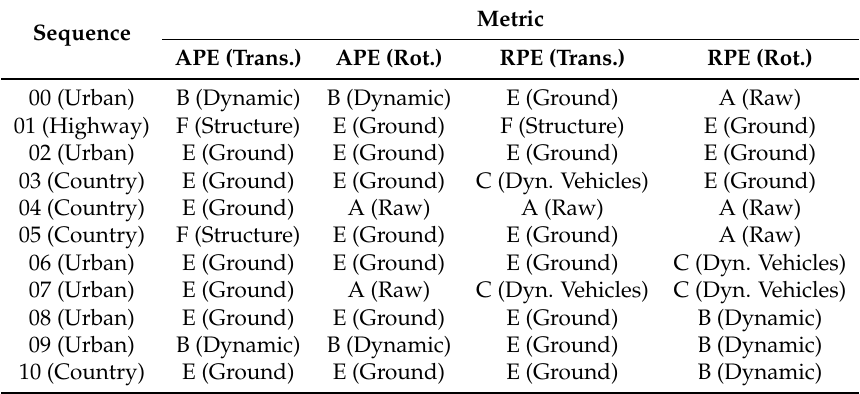
Table 3. Best configuration grouped for each sequence and each